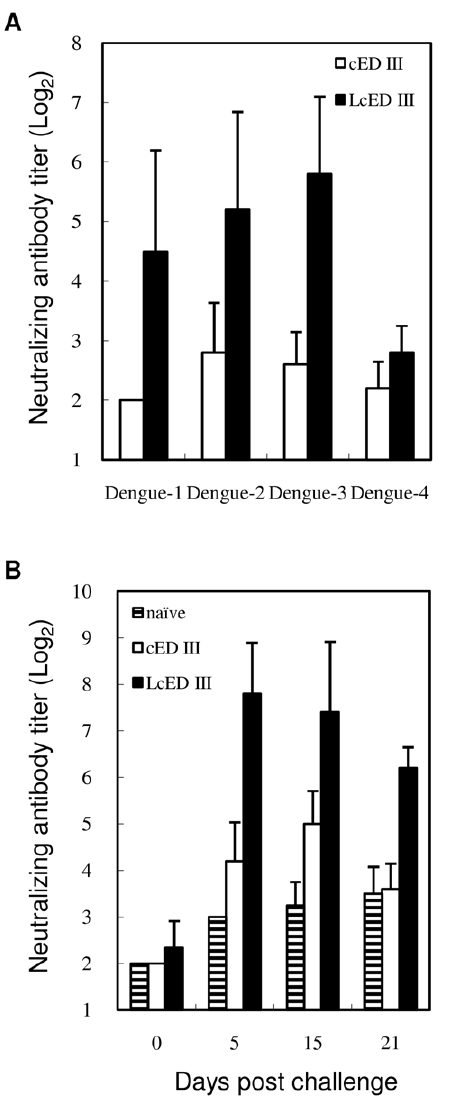
Figure 4. Induction of cross-neutralizing antibodies and memory neutralizing antibodies by vaccination with LcED III. BALB/c mice (n=5) were immunized subcutaneously with 20 m g of cED III or LcED III two times at a two-week interval. (A) Sera samples were collected two weeks after the last immunization. (B) Immunized mice were inoculated intraperitoneally with 5 6 10 6 FFU oflive dengue-2 virus at week 28 post-priming. Sera obtained from naı¨ve mice inoculated with live dengue-2 virus served as controls. Serum samples were collected from each mouse to evaluate neutralization of the infectivity of dengue virus by FRNT.Theneutralizingantibodytiterwascalculatedasthereciprocal ofthe highest dilution that resulted in a 40% reduction of FFU compared to that of a control that consisted of treatment with virus and pre-immunization sera. Values are representative of two independent experiments.